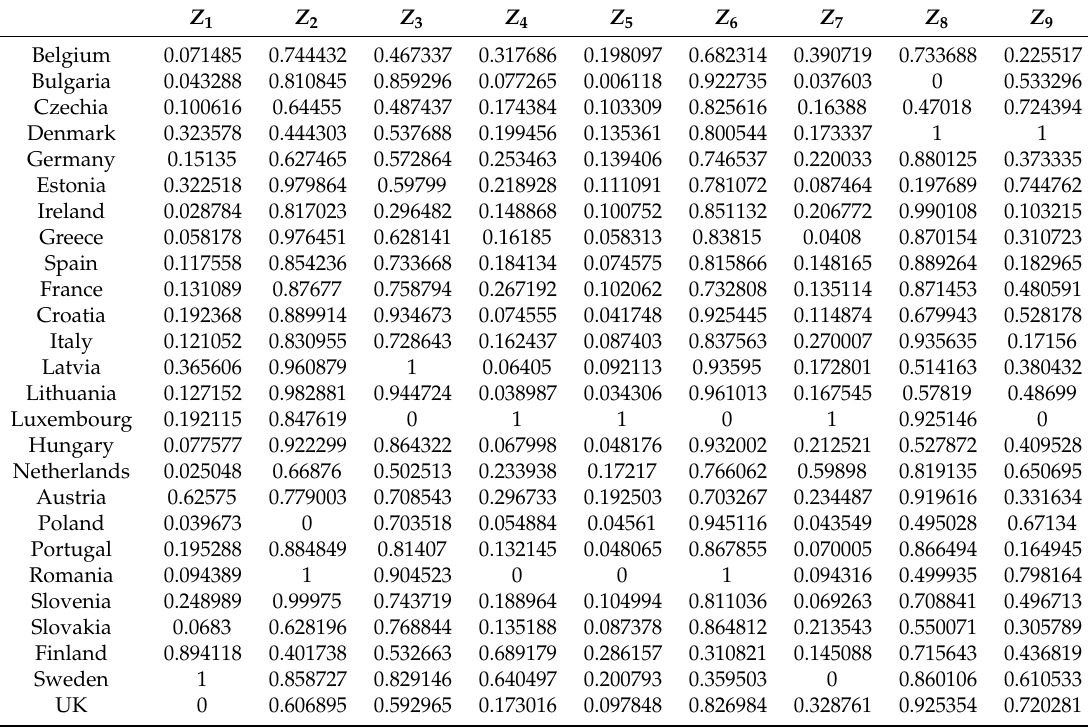
Table 4. The set of variables standardized for a 2010 year (own